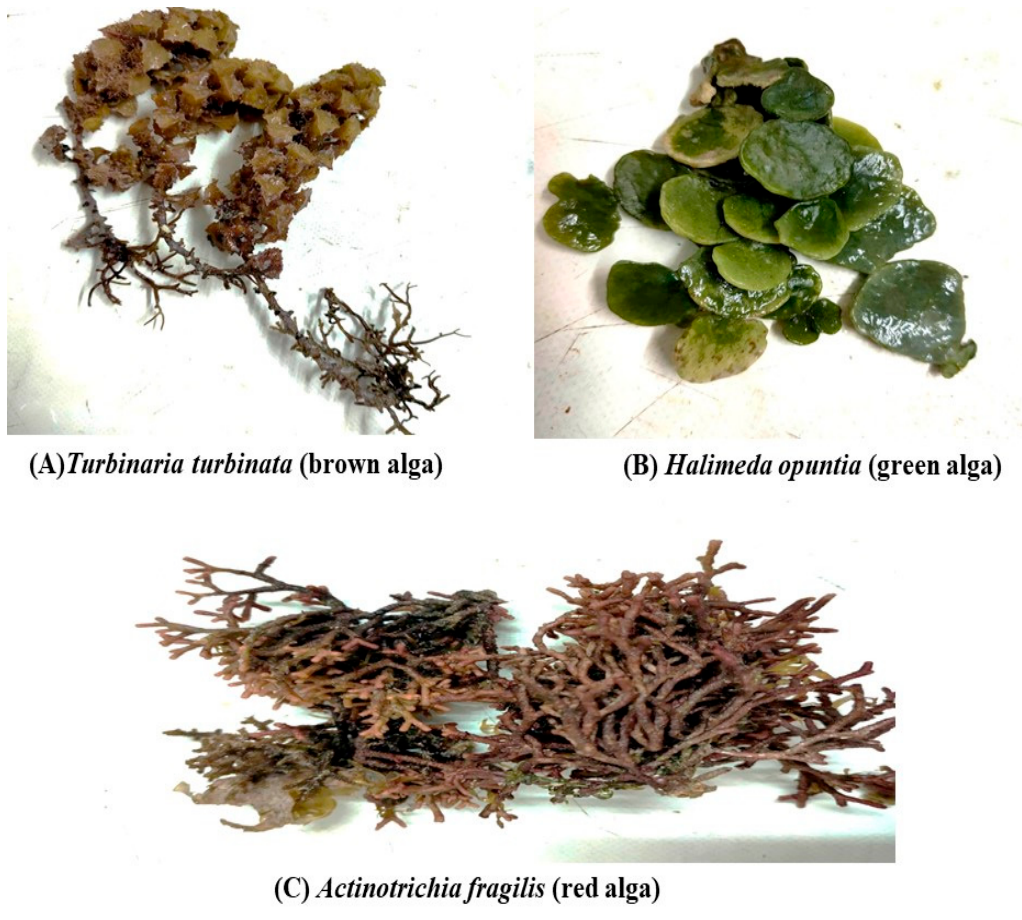
Figure 1. Pictures of the seaweeds investigated in the study: ( A ) Turbinaria turbinata (TT) (brown alga); ( B ) Halimeda opuntia (HO) (green alga), and ( C ) Actinotrichia fragilis (AF) (red alga).